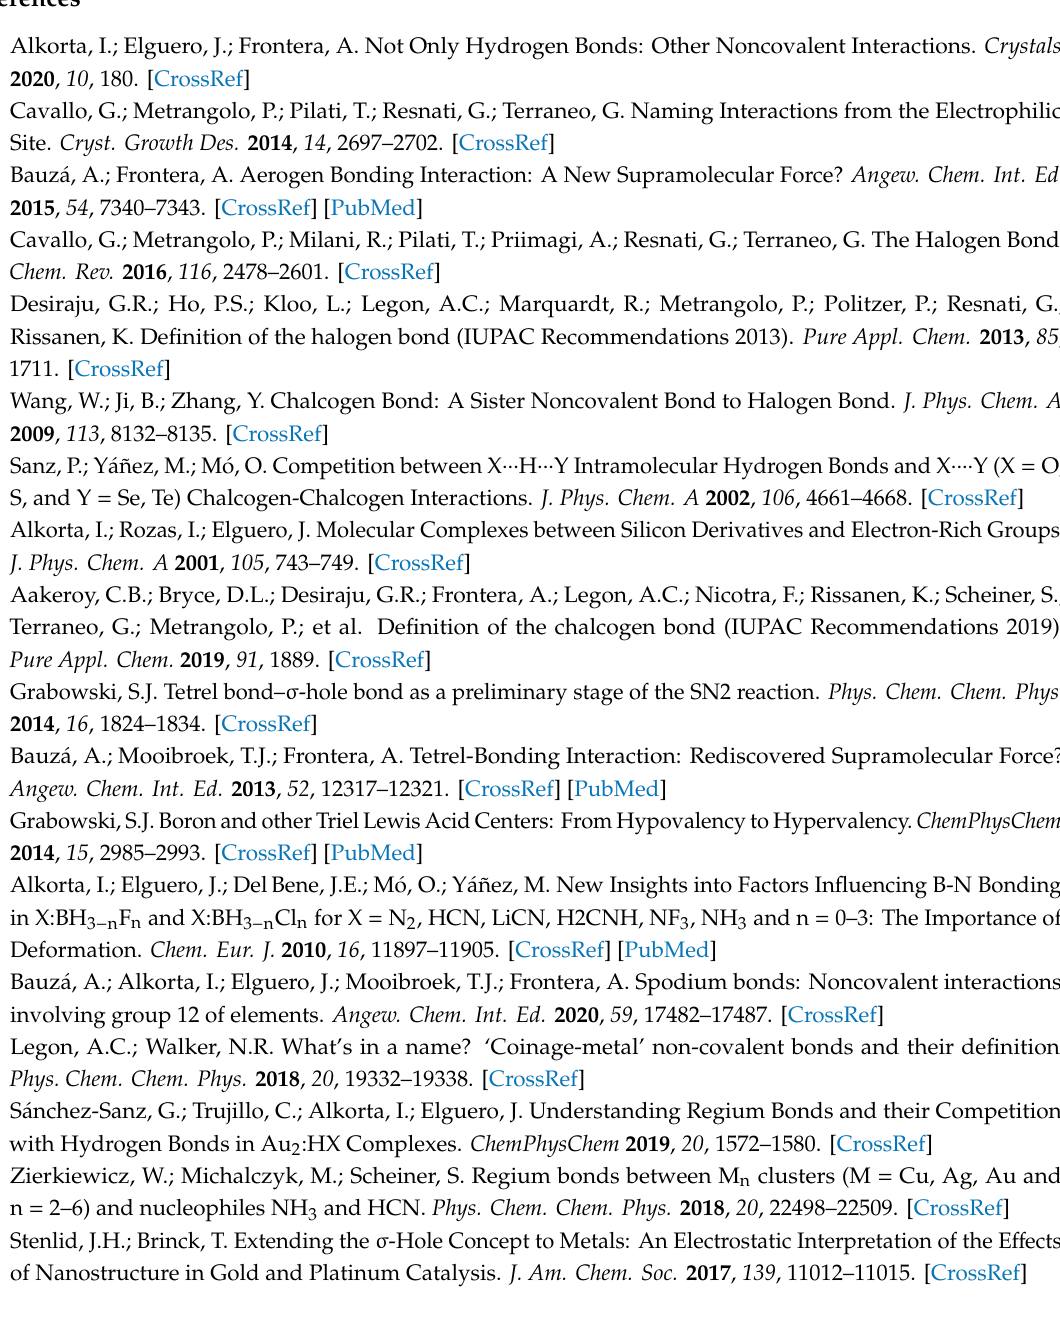
Table S1. Energy (a.u.) of the LUMO of the B9H11C2Be isomers, Table S2. Molecular graphs and optimized Cartesian coordinates (Å) of the complexes, Table S3. Electron density (au) at the BCP between the Be atom and the Lewis base, Table S4. LMOEDA energy terms (kJ · mol − 1 ), Table S5. Dissociation ∆ G energies (kJ · mol − 1